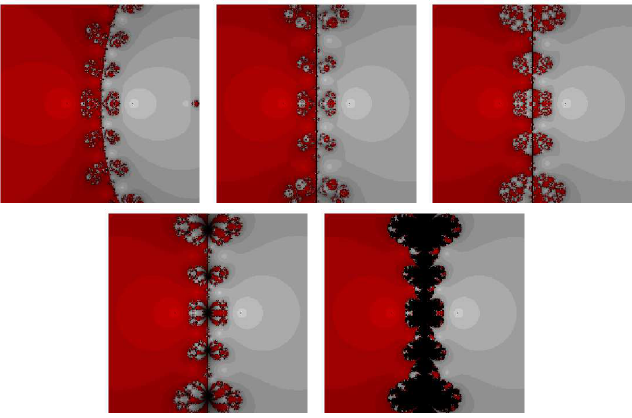
our method OM 4 has lesser chaotic behavior and larger basins of attraction as compared to other methods namely, LM 4 , SSM 4 , ZM 4 and SM 4 . Further, our method has no divergent point in this particular region while SM 4 has many divergent points.